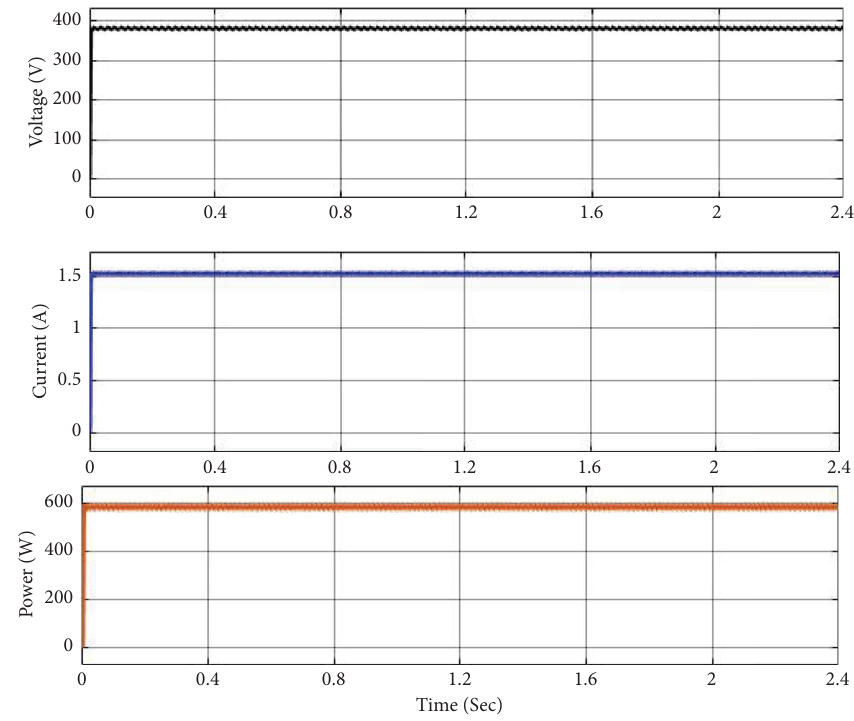
Figure 15: Output voltage, current, and power at load.